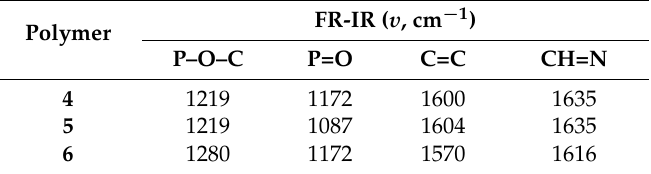
Table 3. Some FT-IR spectral data for phosphate polymers 4 – 6 .